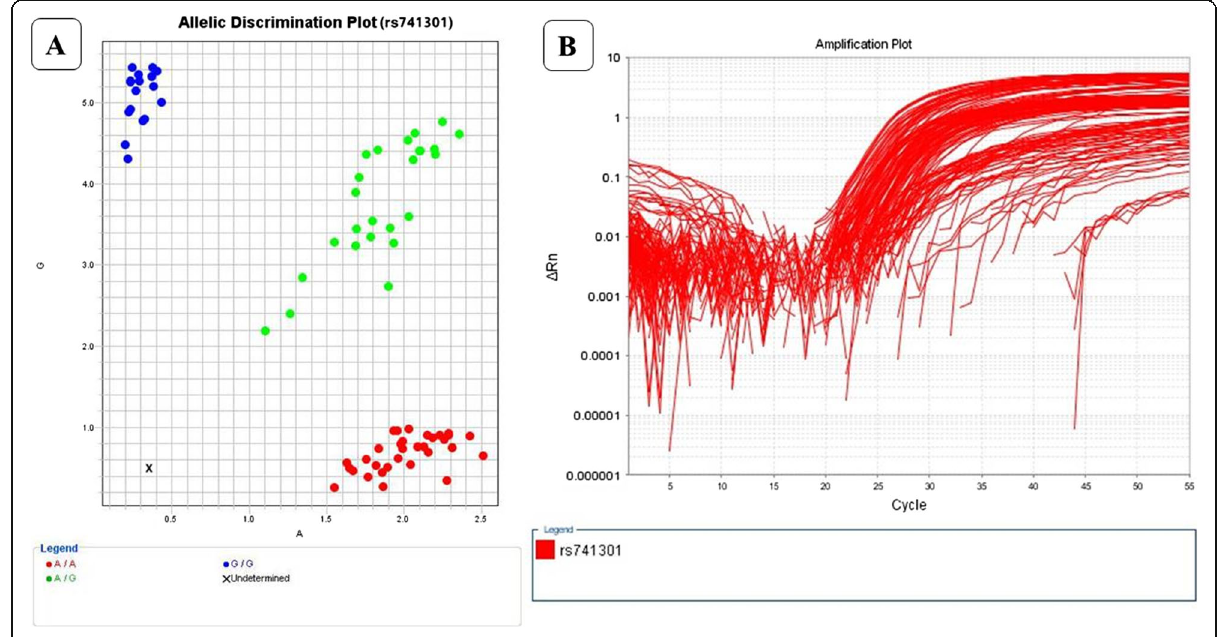
Fig. 1 a Allelic discrimination plot of ELMO1 rs741301. b Amplification plot of ELMO1